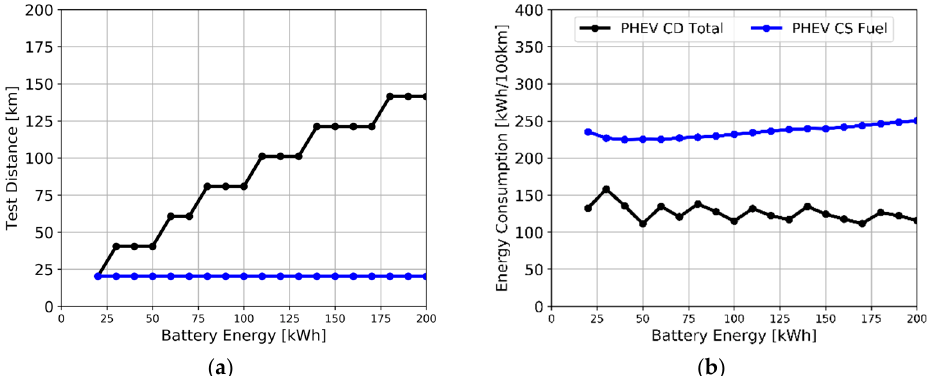
Figure 10. Plug-in hybrid truck under a WHVC and 50% cargo mass in charge depleting (CD) and charge sustaining (CS) modes, in terms of distance travelled ( a ) and energy consumption ( b ).